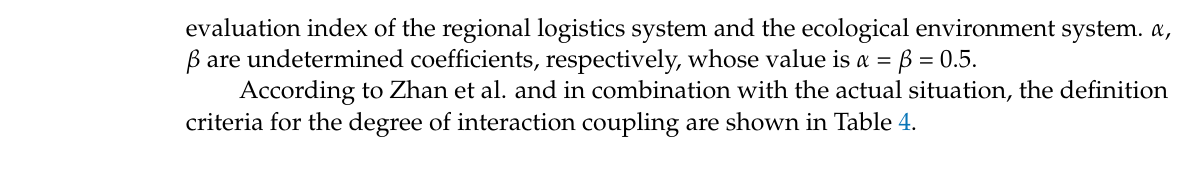
Table 4. Classification of coupling coordination